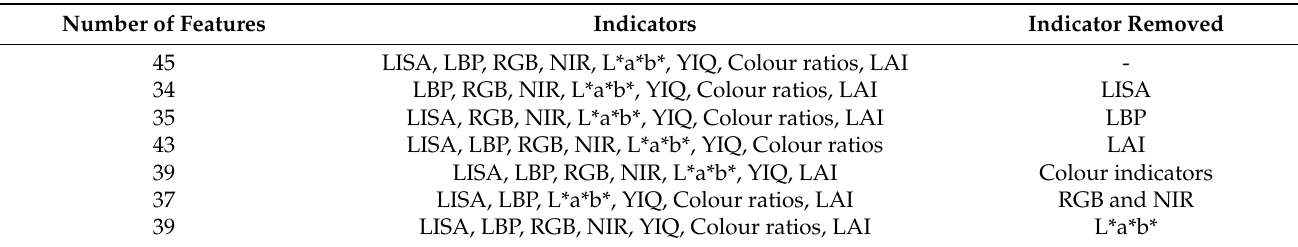
Table 4. Set of evaluated